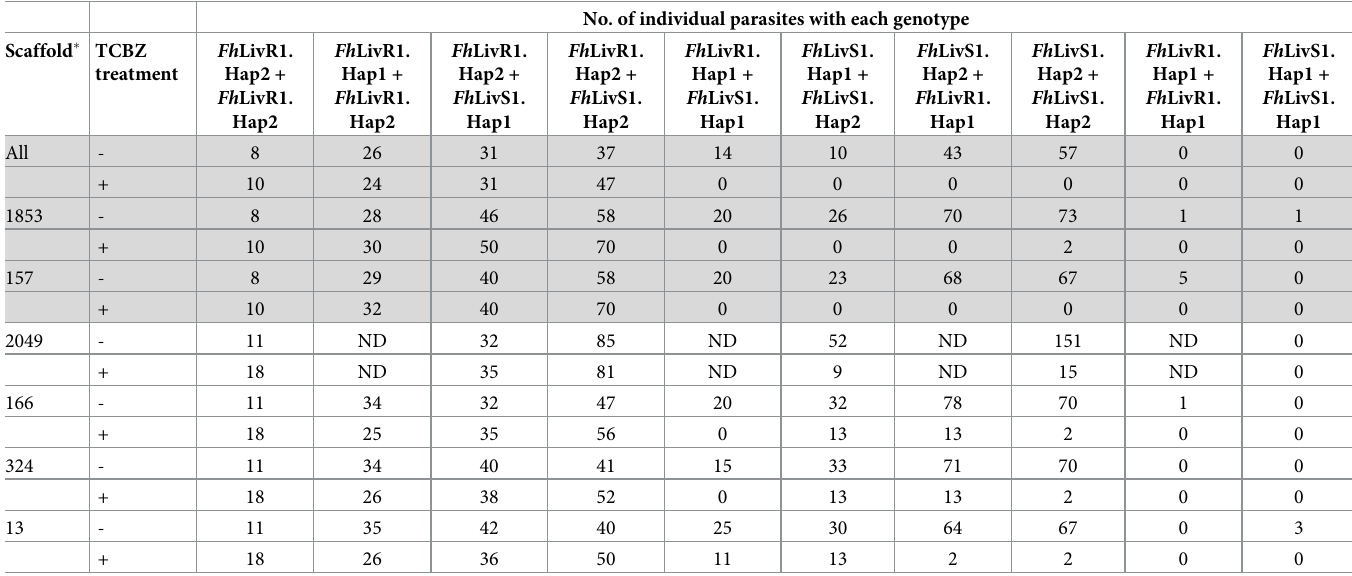
� Scaffold location for each SNP haplotype. ND = not determined due to inability to differentiate between Fh LivR1.Hap1 and Fh LivS1.Hap2 haplotypes on this scaffold. Shaded region = resistant parasites (those surviving drug treatment in vivo) had to have at least one copy of Fh LivR1.Hap2.